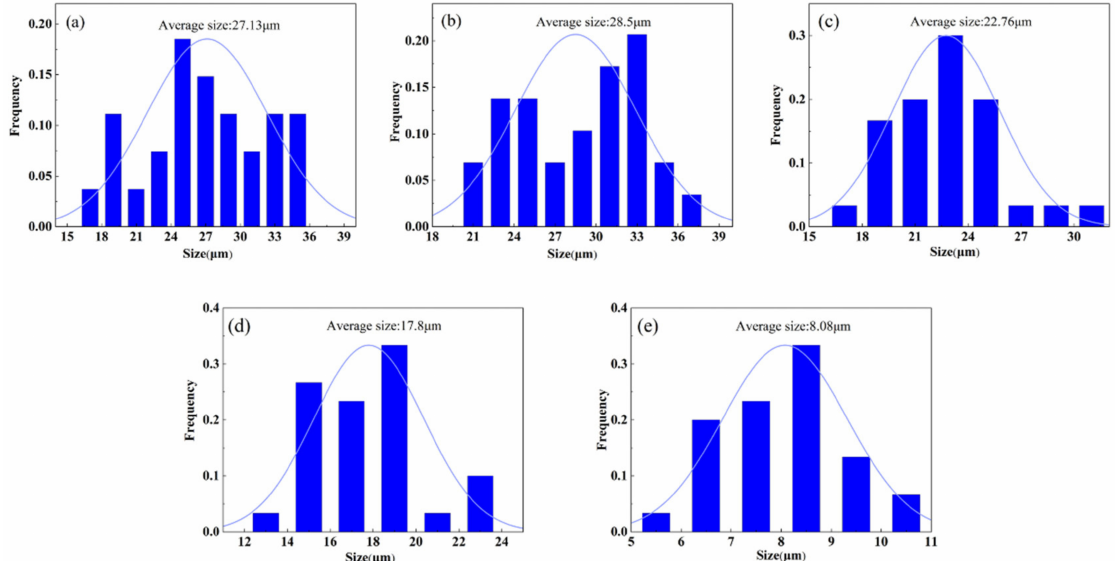
Figure 15. The dimple size distribution histograms of fractographies in Zr-4Hf-3Nb (wt%) alloy with various cooling rate: ( a ) FC-1, ( b ) FC-2, ( c ) FC-3, ( d ) AC, and ( e )